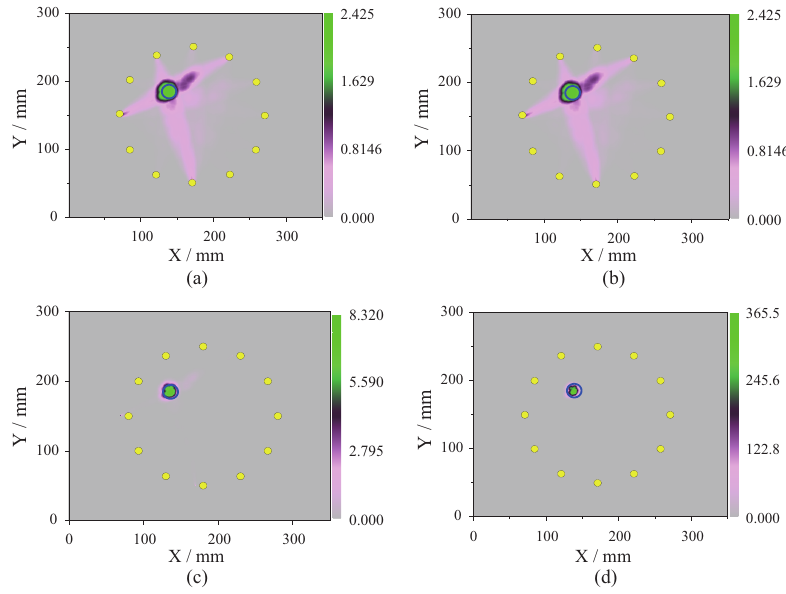
Fig. 14. The influence of the image enhancement factor α on the imaging result. (a) α = 1; (b) α = 3; (c) α = 5; (d) α = 10.